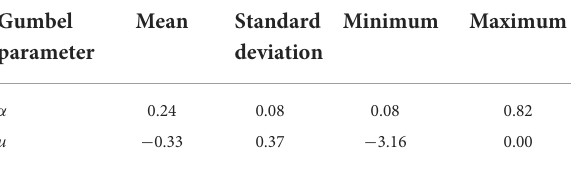
TABLE 3 Descriptive statistics of α and u for the location (cells) flooded by more than one return period in the Metairie, Louisiana, study area.